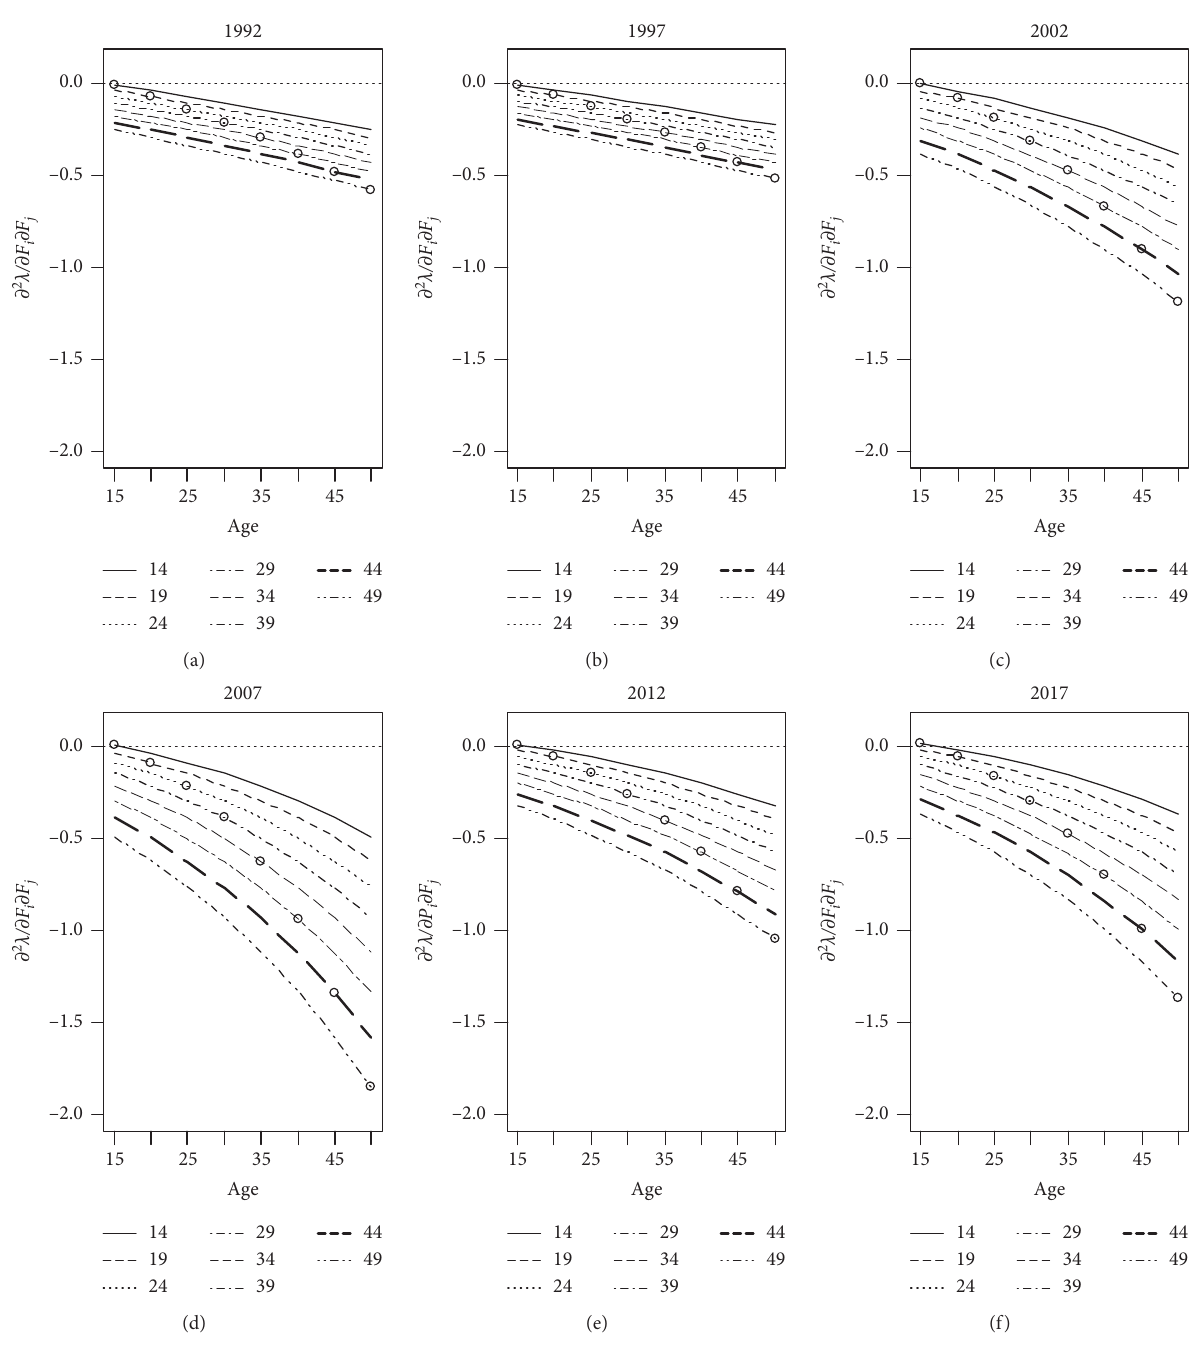
Figure 8: PGR second derivatives with respect to pairs of